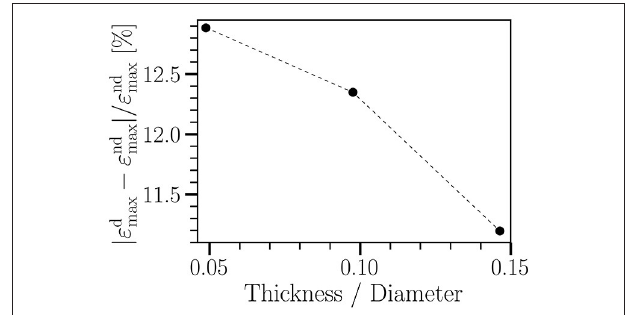
FIGURE 2 | Relative change in radial strain of a straight tube between non-degraded ( ε nd ) and degraded ( ε d ) cases vs. wall thickness of the tube. The tube diameter is 0.41 cm. The wall thickness varies from 0.02 cm to 0.06 cm. The imposed cyclic load ranges from 8.7 kPa to 20 kPa, having the same waveform as shown in Figure 1A . Each simulation runs for five cycles. T = 0.8 s; γ ∞ = 18 kPa. Other material parameters are given in Table 1 . TABLE 1 | Material parameters for the aneurysm region (colored in blue in Figures 1B–D ) used in this study [based on data shown in Balzani et al.